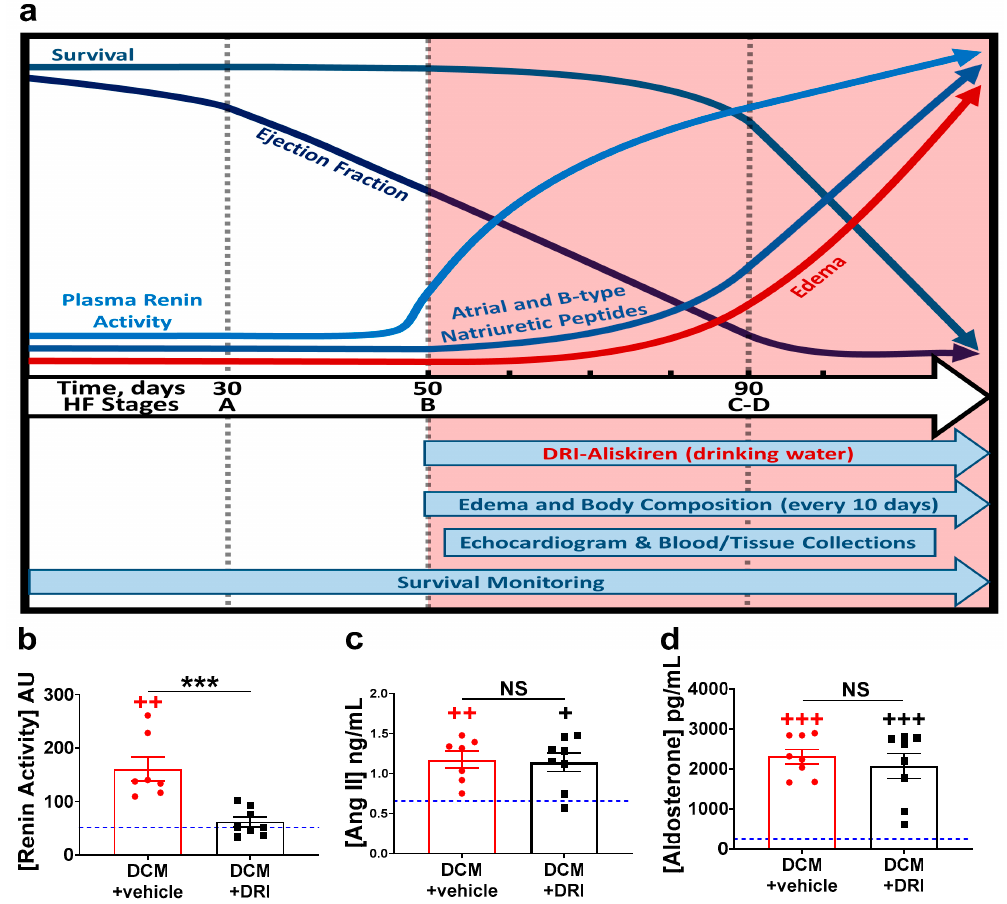
Figure 1. Heart failure stages, study design, and effects of aliskiren, a direct renin inhibitor (DRI). ( a ) Schematic overview of the natural history of heart failure (HF) progression, biomarker changes, and experimental design (salmon-colored area), in an established model of dilated cardiomyopathy (DCM) in female mice as reported [27]. Mice with DCM were randomly treated with aliskiren (DCM + DRI) or nothing (DCM + vehicle) in drinking water (see Methods Section). Black hash-marks indicate time points for measurement of body composition, while echocardiography and blood-tissue collection were completed at 90 days. The impact of aliskiren treatment on plasma ( b ) renin activity, ( c ) angiotensin II (Ang II), and ( d ) aldosterone levels at 90 days. The number of DCM mice is indicated. For reference, values for wild-type (WT) littermates are shown as a blue line ( n = 4). Data analyzed with one-way ANOVA and represented as mean ± SE. Not significant (NS), ++ p < 0.01, +++ p < 0.001 (red, WT vs. DCM+vehicle; black, WT vs. DCM+DRI), *** p < 0.001 (DCM+vehicle vs. DCM+DRI).